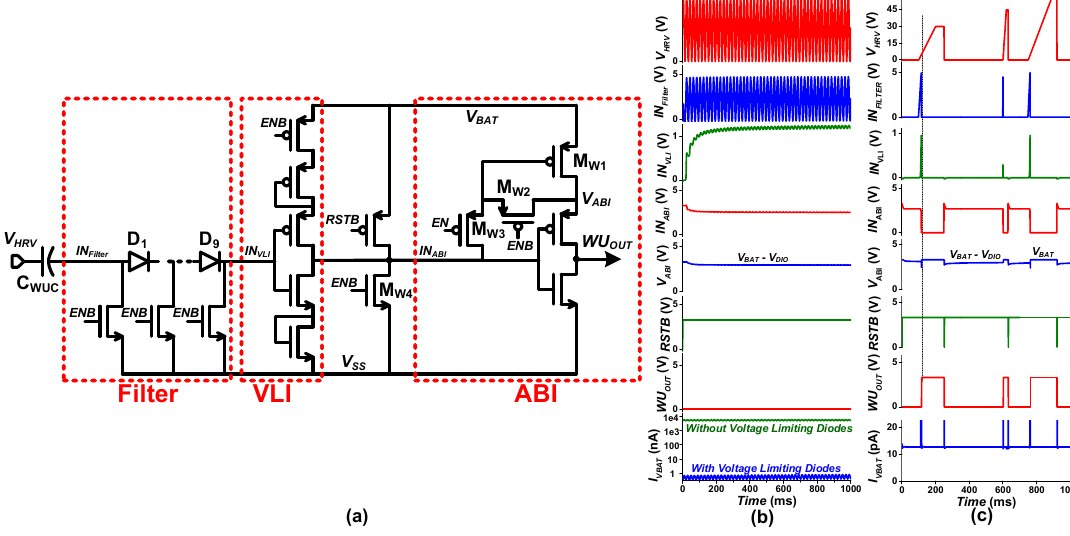
Figure 6. Proposed low quiescent current wake-up controller (WUC): (a) Circuit, (b) Non-harvestable low voltage input waveforms, (c) Normal operation waveforms.